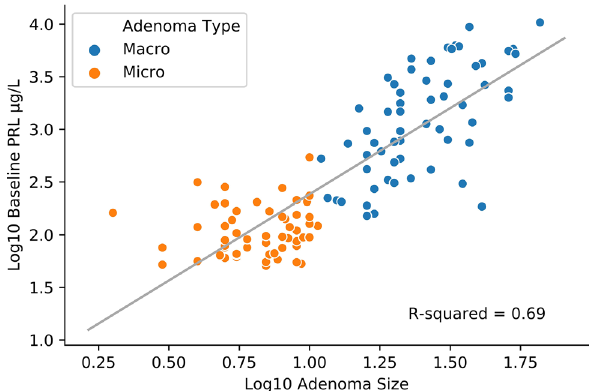
Figure 3. Correlation between baseline serum PRL concentrations and adenoma size—grouped by adenoma type.